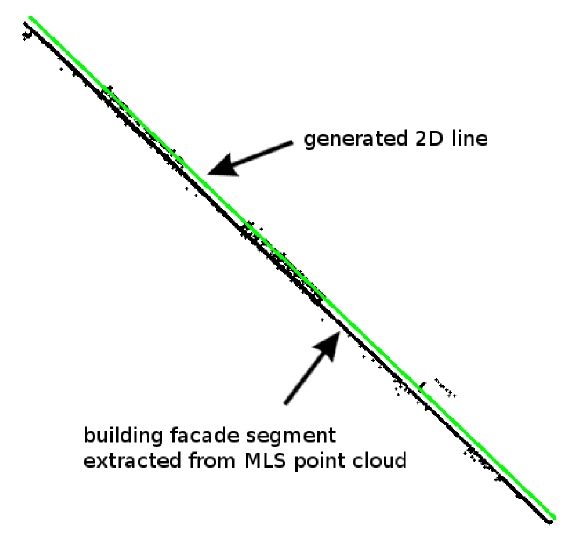
Figure 4. 2D GIS-ready information in the form of vector lines of each detected building facade segment is